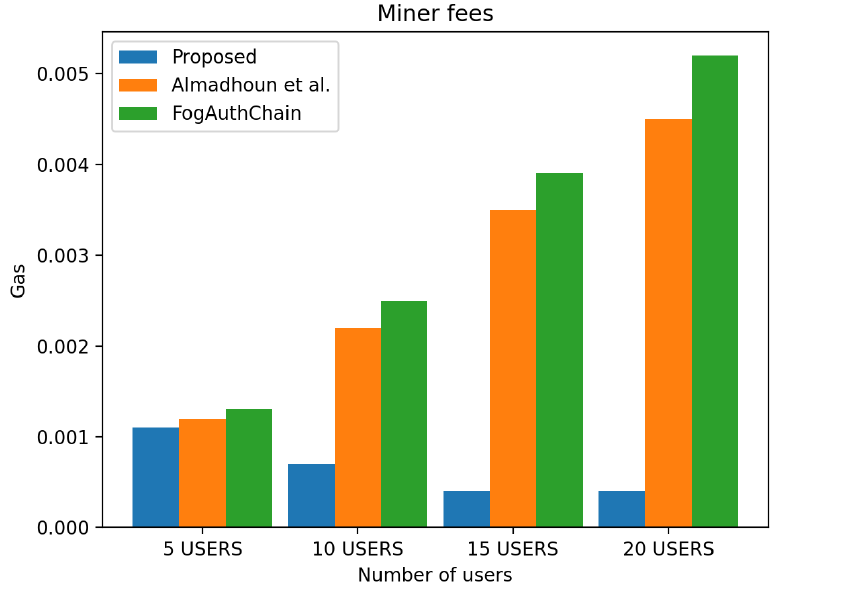
Figure 9. Comparison of experimental results of the proposed system and existing systems (Almad- houn et al. [36] and FogAuthChain [1]) on registration miner